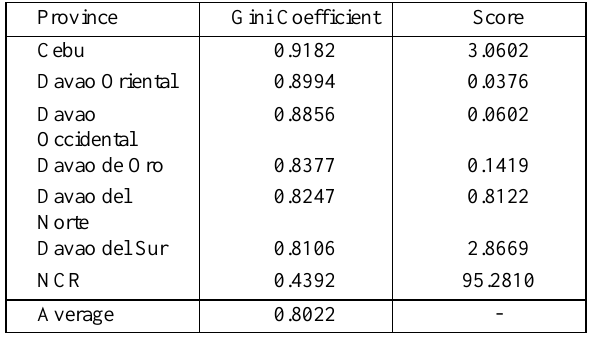
Table 1: Gini Coefficients and Health Accessibility Scores for National Capital Region, Davao Region, and Cebu